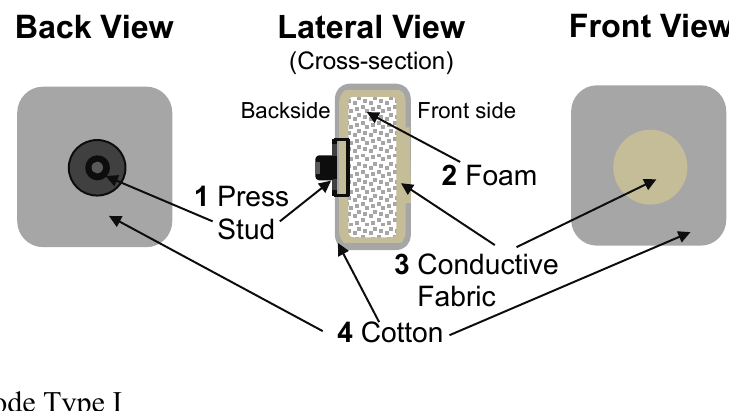
Figure 5. Schematic structure of the textrodes used in this